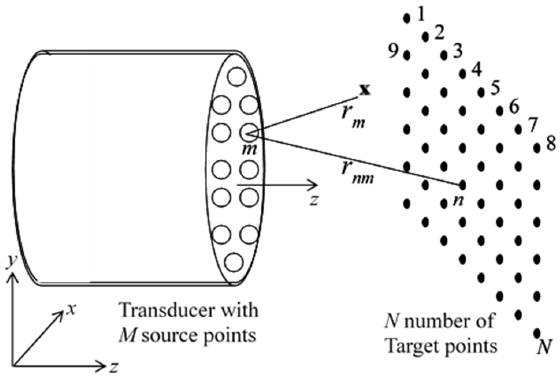
Figure 1. M point sources are placed slightly behind the transducer face and the ultrasonic field is computed at N target points in front of the transducer. computed at N target points in front of the